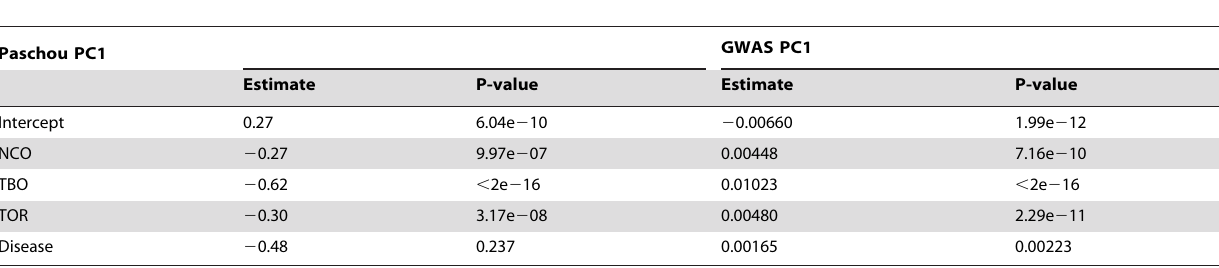
Table 1. Association of PC1 from Paschou and GWAS PCAs on site and disease status.